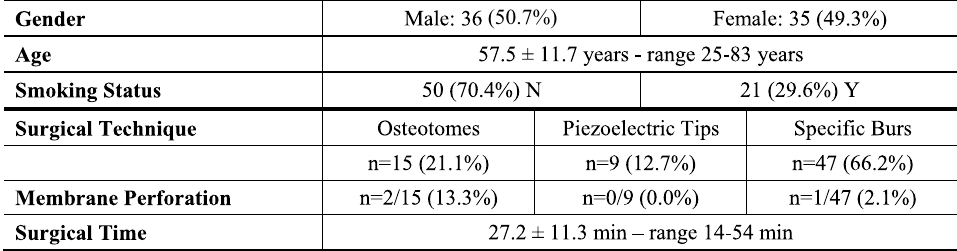
Table 1 Demographic and surgical characteristics of the included patients